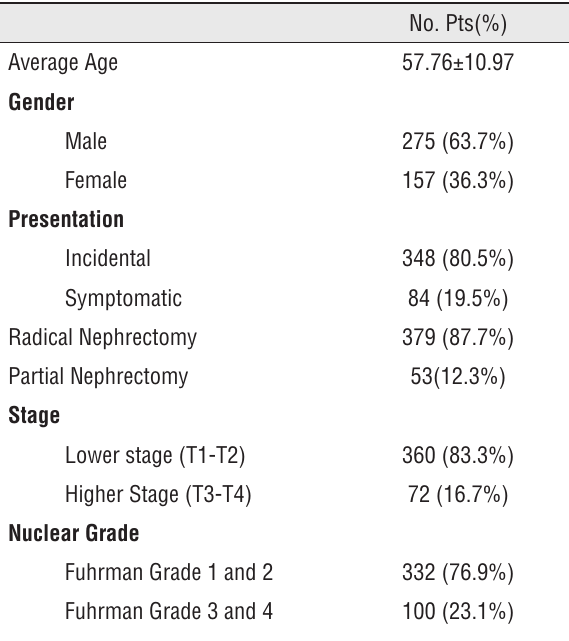
Table 1 - patient characteristics and pathological findings.